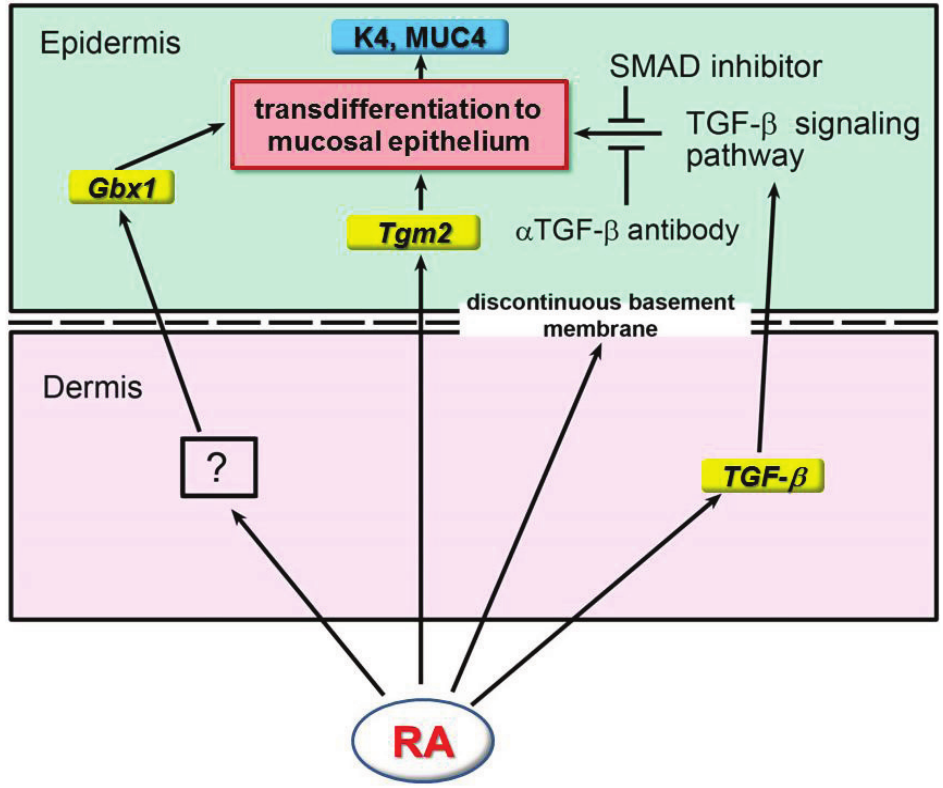
Figure 2. Schematic diagram summarizing the effect of RA on epidermal mucosal transdifferentiation. RA up-regulates the expression of Tgm2 and TGF- β in the epidermis and dermis, respectively, after 8 – 24 h of treatment, which is followed by the appearance of a discontinuous basement membrane. On the other hand, Gbx1 expression is up-regulated in the epidermis after 8 h by an unknown factor, which is induced in the dermis by RA [21]. The TGF- β signaling pathway activated by TGF- β and acting together with Gbx1 induces epidermal transdifferentiation to an esophagus-like mucosal epithelium [22] (reproduced with permission from Int. J. Dev. Biol. 2011 , 55 , 933 –